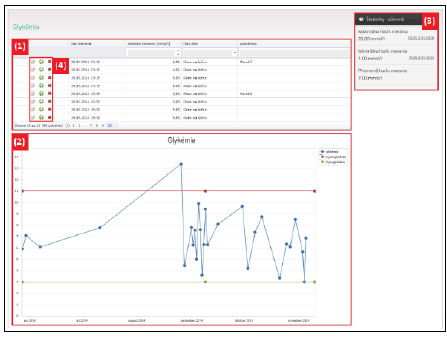
Figure 4. PMU web interface displaying development of blood